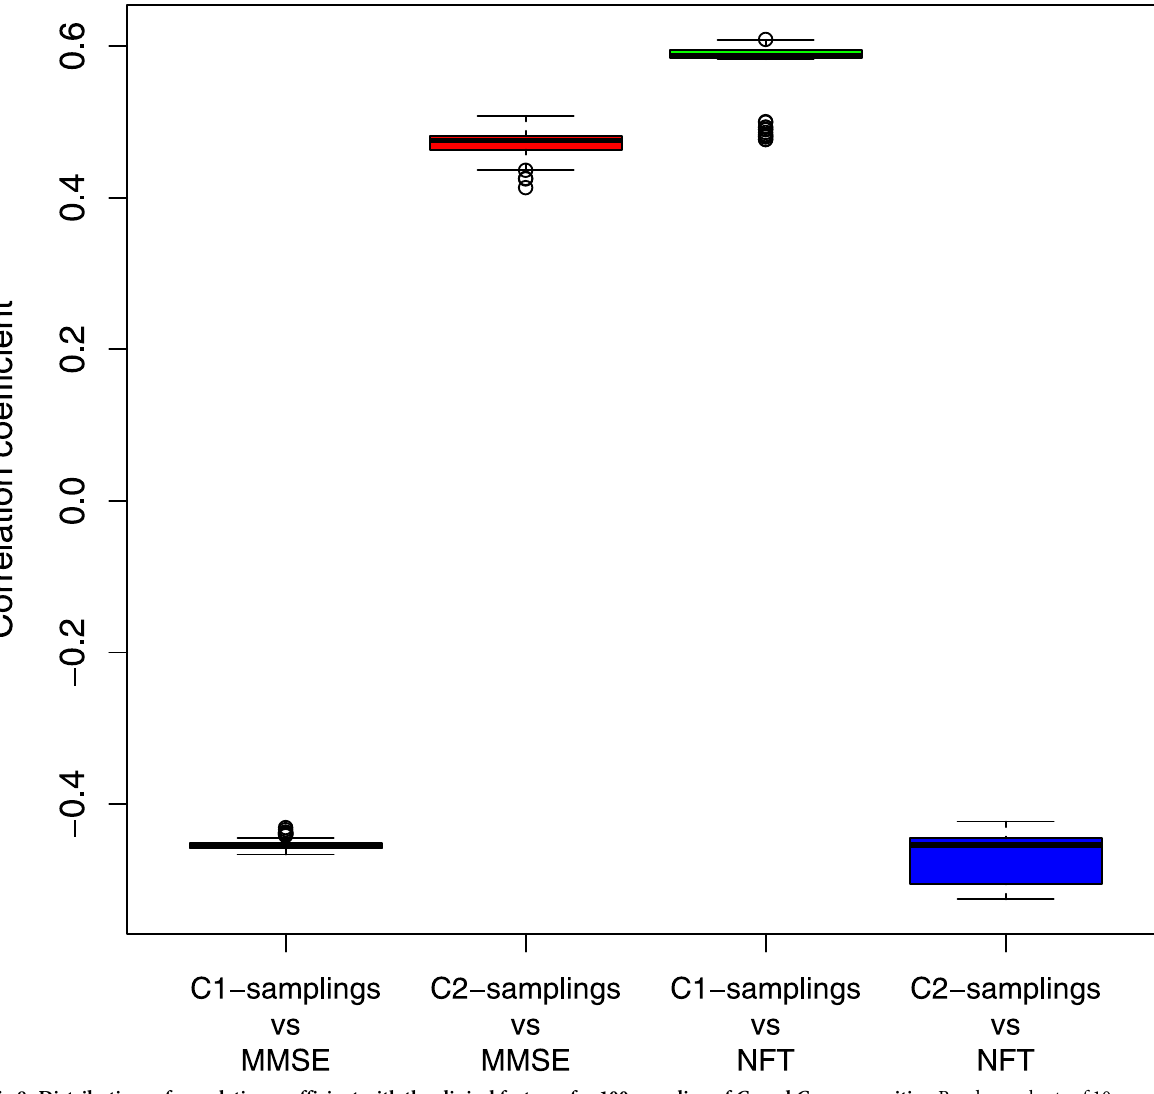
Fig 8. Distributions of correlation coefficient with the clinical features for 100 sampling of C 1 and C 2 communities. Random subsets of 10 genes are removed from C 1 and C 2 communities before to compute the first principal